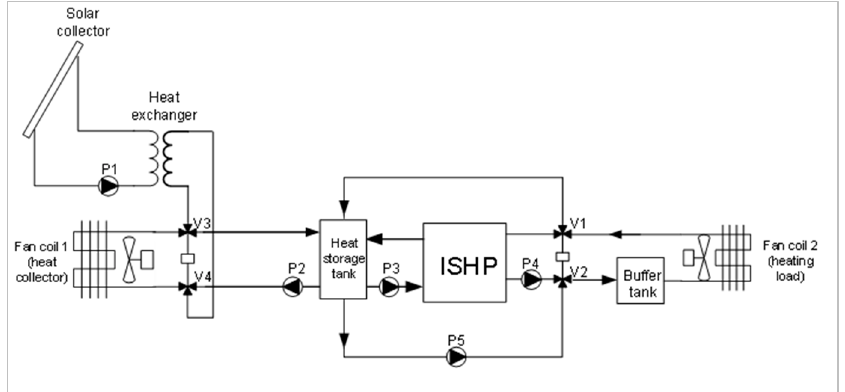
Figure 1. Schematic diagram of the solar heating system with ISHP.